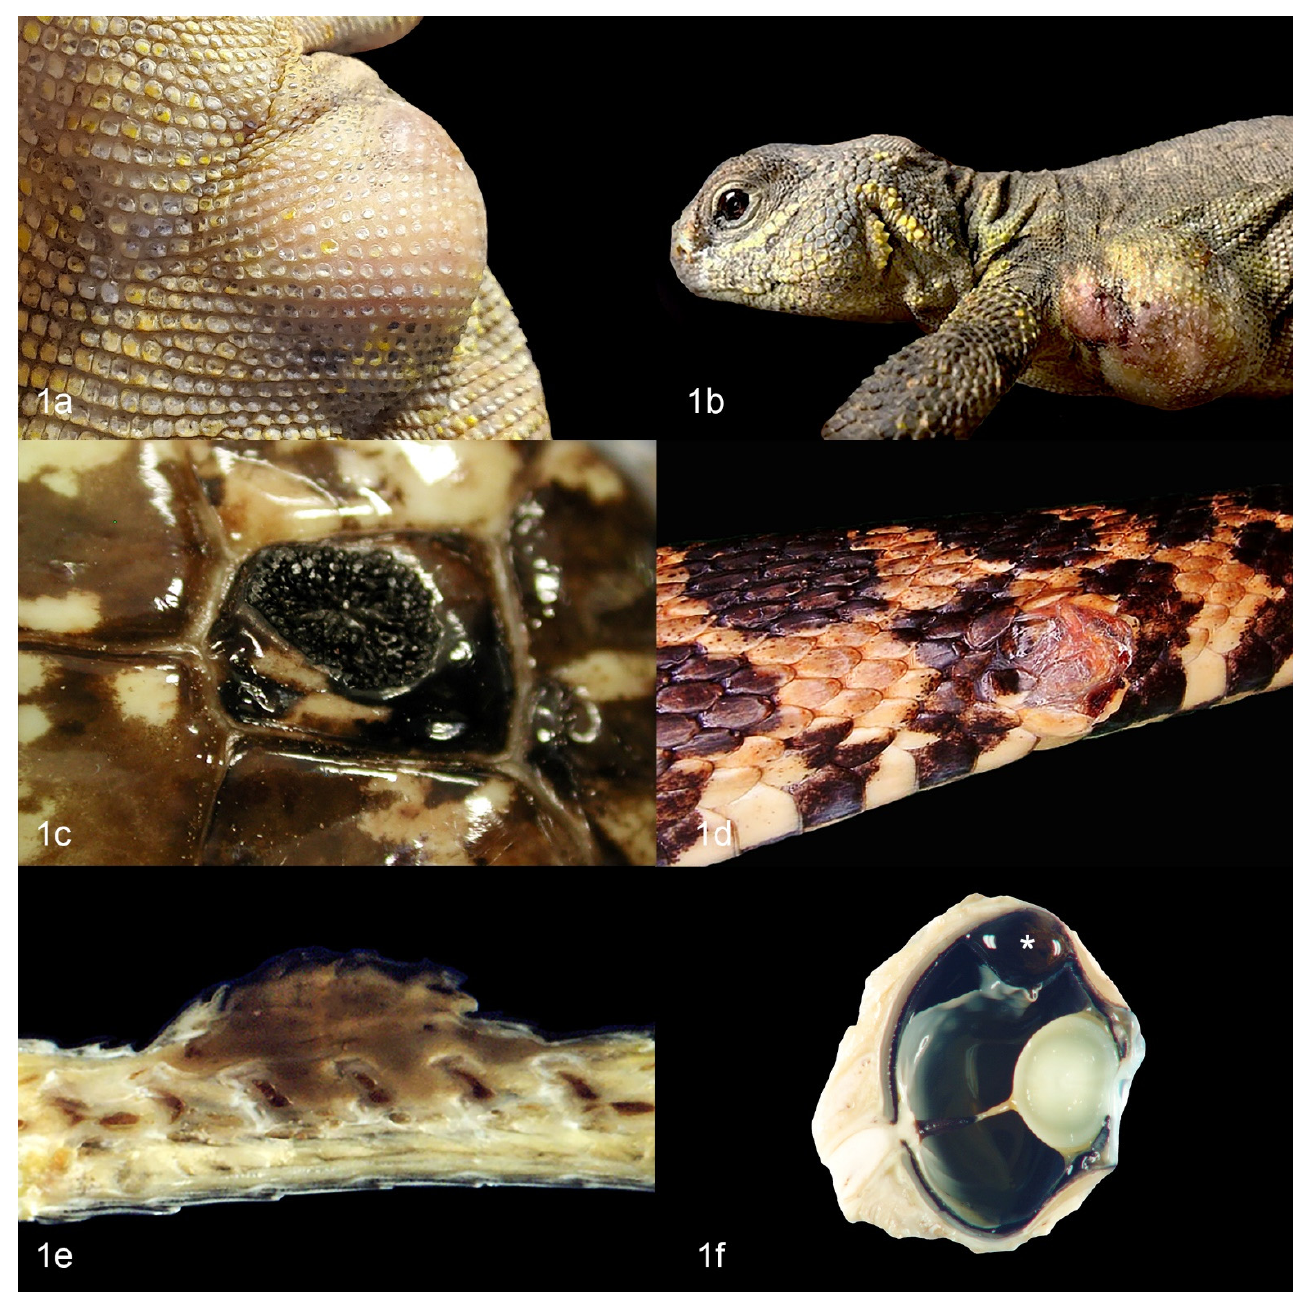
Figure 1. Gross appearance of cutaneous chromatophoromas in reptiles. ( a ) Cutaneous iridophoroma on the axilla of an Uromastyx ( Uromastyx geyri ). ( b ) Cutaneous chromatophoroma on the axilla of an Uromastyx ( Uromastyx geyri ). ( c ) Cutaneous melanoma on the body wall of a cape cobra ( Naja nivea ). ( d ) Cutaneous melanoma on the body wall of a western fox snake ( Pantherophis spp.). ( e ) Cross section of cutaneous melanoma on the dorsum of a rat snake ( Elaphe [Pantherophis] obsolete ). The tumor extends into the underlying connective tissues between the dorsal spinal facets. ( f ) Uveal melanoma (asterisk) from a bearded dragon ( Pogona sp).